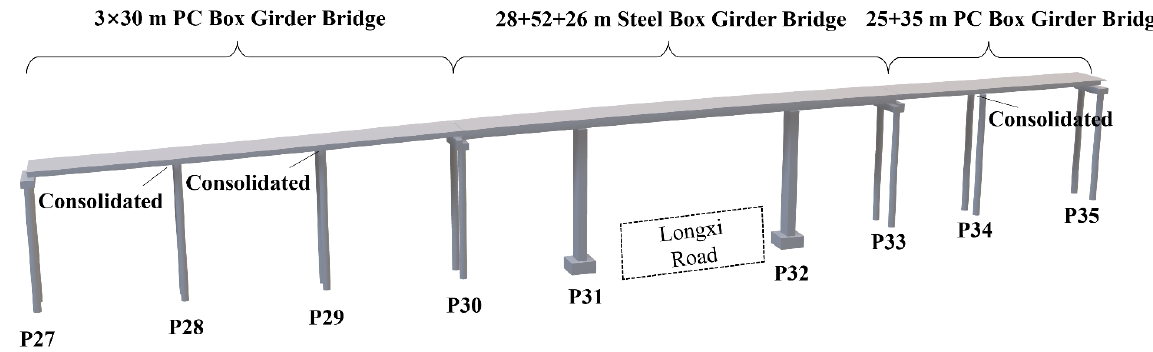
Figure 2. Layout of the ramp.